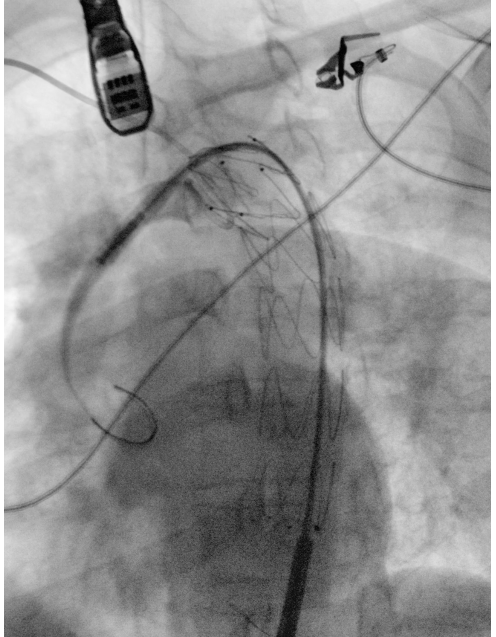
Fig. 2C - Intraoperative transesophageal echocardiography showing complete exclusion of aortic mural thrombus after endograft deployment. Short axis (left) Fig. 2B - Angiogram showing graft deployment and long axis with descending thoracic aortic thrombus exclusion.